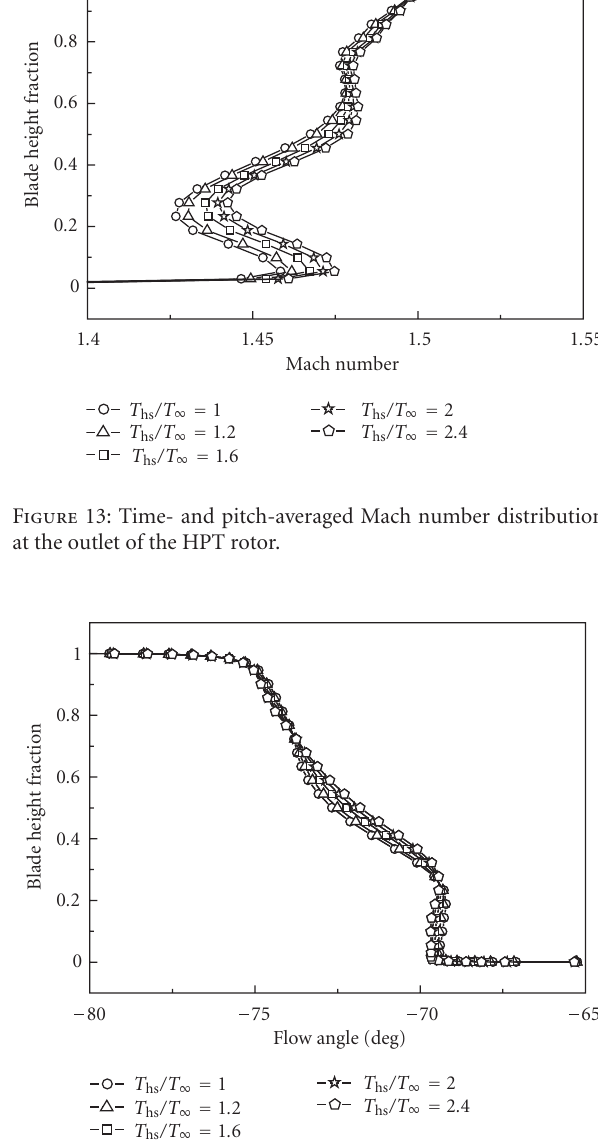
Figure 14: Time- and pitch-averaged flow angle distributions at the outlet of the HPT